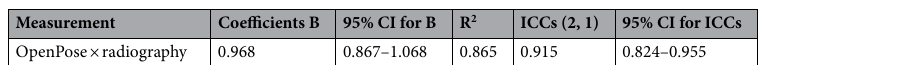
Table 2. Regression models and intraclass correlation coefficients (2,1) between OpenPose and radiography. CI confidence interval, R 2 coefficient of determination, ICCs intraclass correlation coefficients.